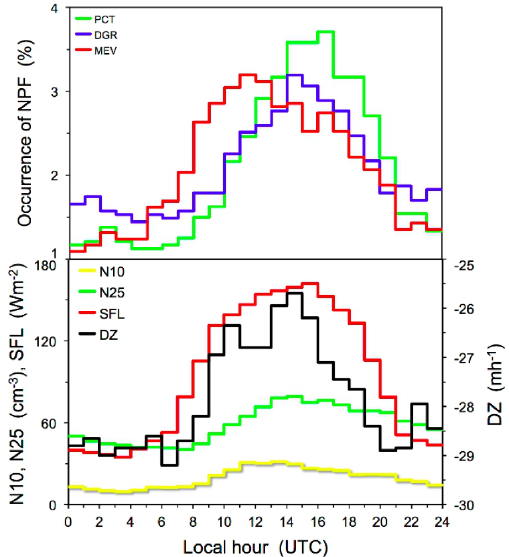
Figure 11. Top: relative average diurnal occurrence of the three types NPF events. PCT: upper percentile of N 25; DGR: diameter growth; MEV: multiple-size events. Bottom: average diurnal varia- tion of the HYSPLIT-modeled solar flux (SFL, Wm − 2 ) , the integral particle concentrations N 10 and N 25 in cm − 3 , and of the vertical displacement parameter (DZ, mh − 1 ) . N 10 is based on data of the years 2011–2015, whereas the other parameters are based on data of the years